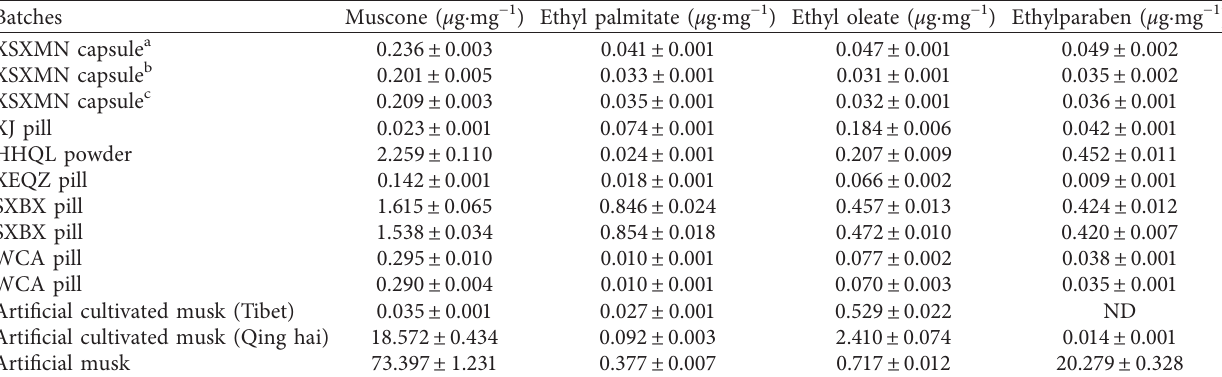
Table 3: The contents of four compounds in 8 batches of Chinese patent medicine and 3 batches of musk samples (mean ± SD, n � 3). Batches